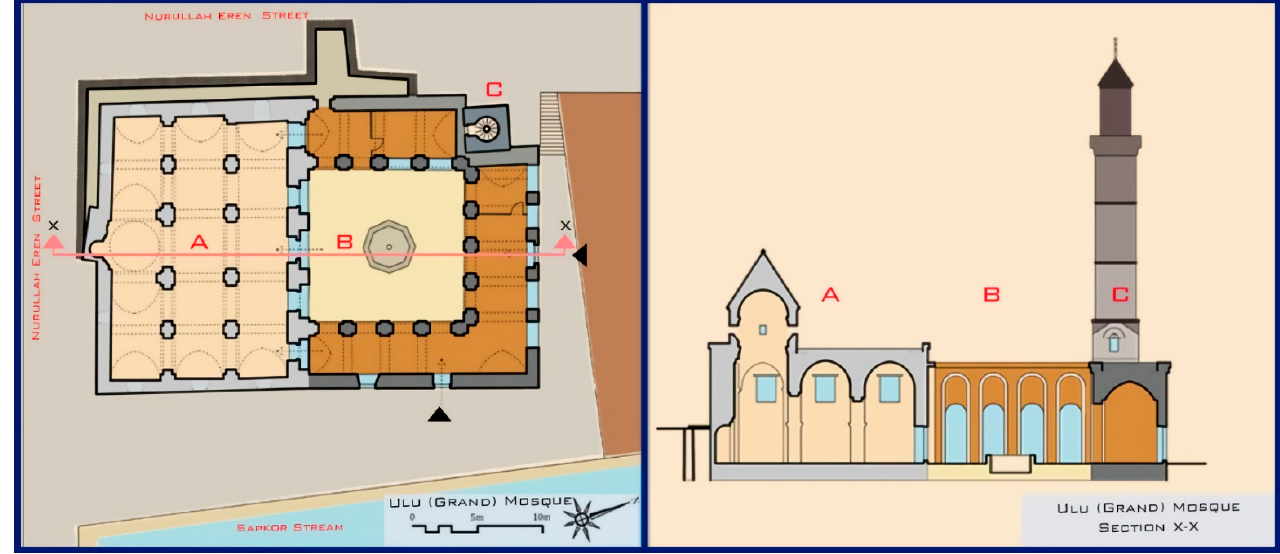
Figure 5. Bitlis Ulu Mosque’s plan and section: (A) sanctuary; (B) portico court; (C) minaret.